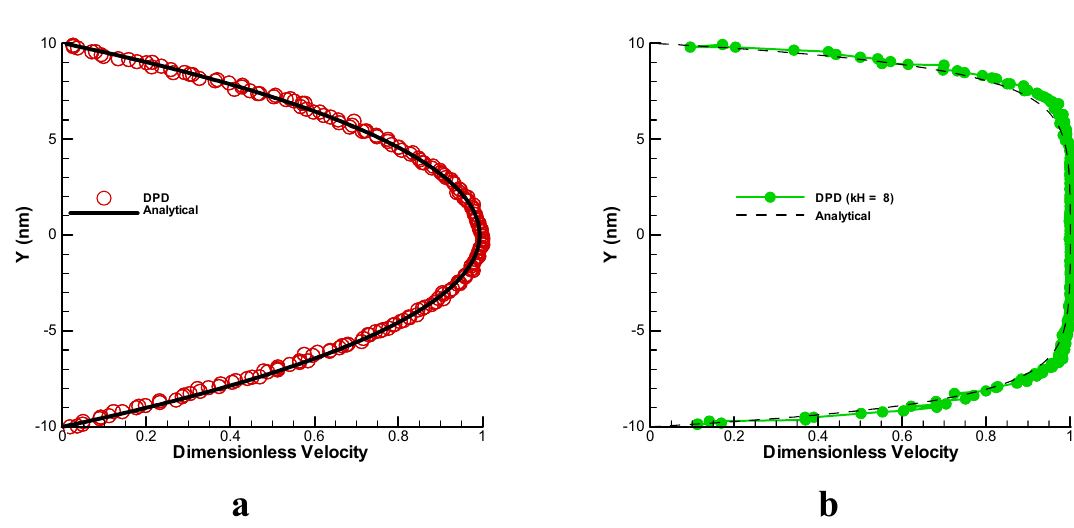
Figure 2. Comparison of DPD (circle) and analytical (continuous line) simulation solution of velocity profiles in simple channel for constant force of 0.01 (( a ), pressure gradient (PG)) and variable force (( b ) electroosmotic force (EOF); zeta potential − 25 mV, electric field 250 V/mm and kh =